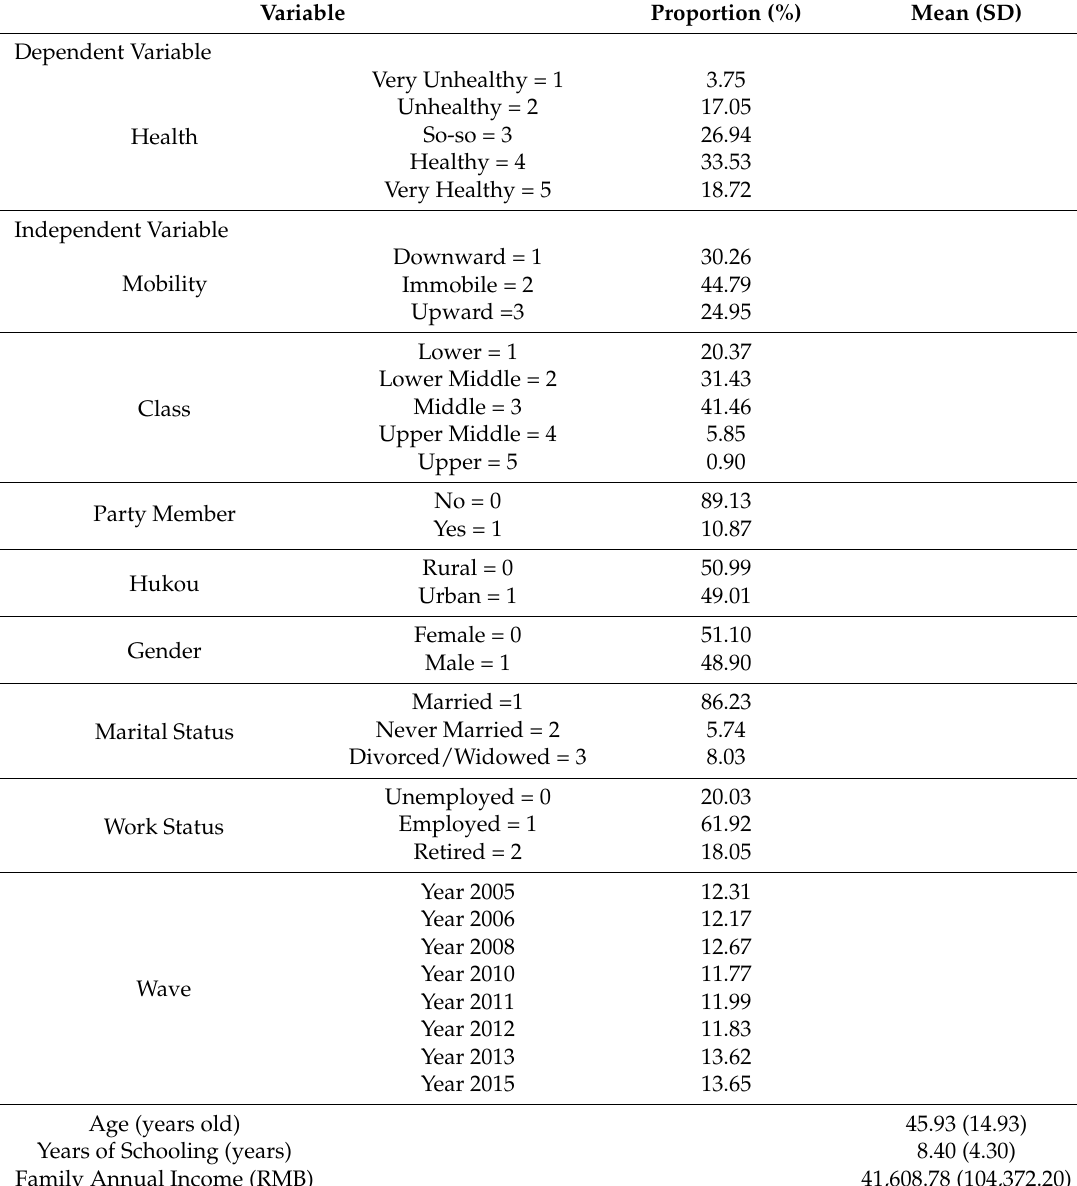
Table 1. Descriptive Statistics for Selected Variables